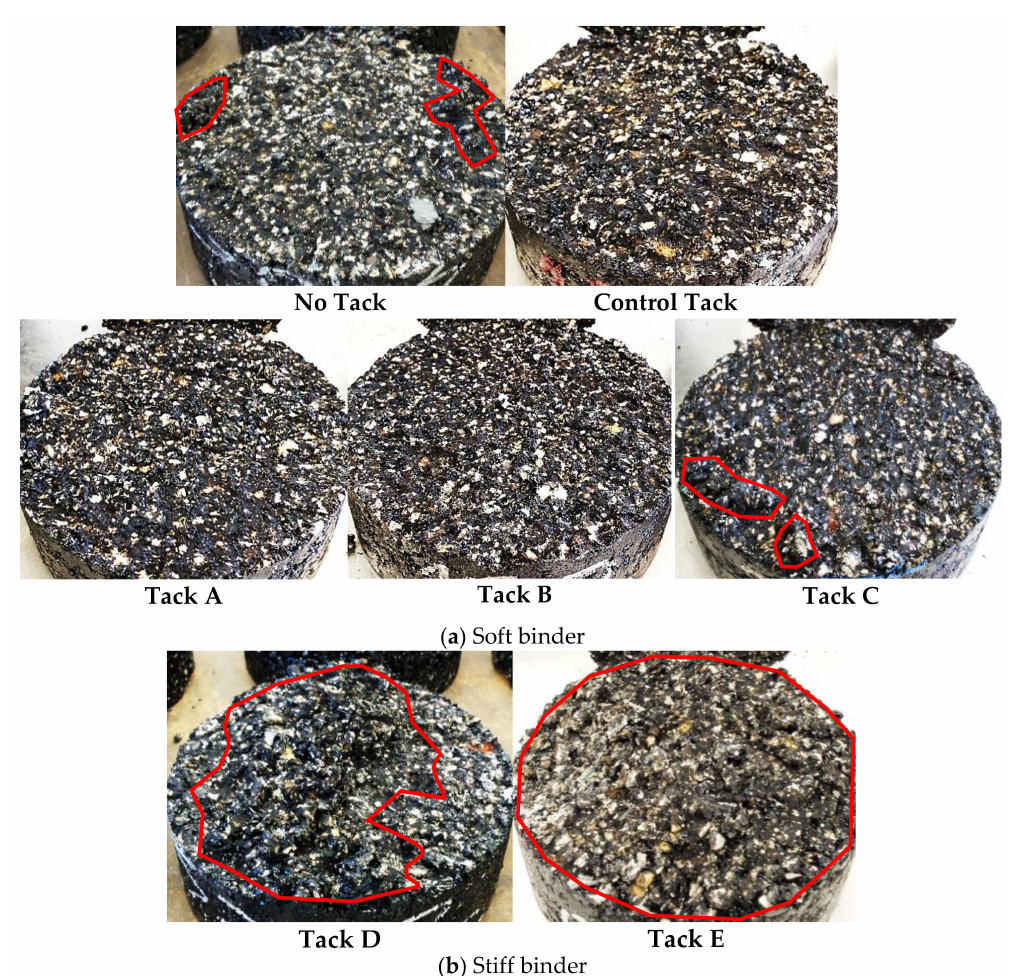
Figure 6. Failure location for laboratory compacted samples applied with different tacks: ( a ) soft binder and ( b ) stiff binder groups. Note: red marked areas indicate the failure through the overlay